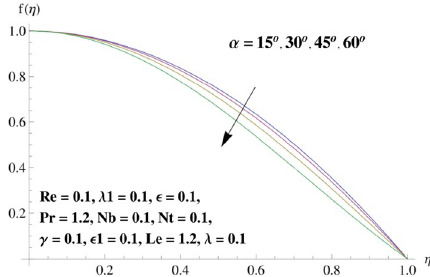
Figure 3. Behavior of f (η) against α > 0 .